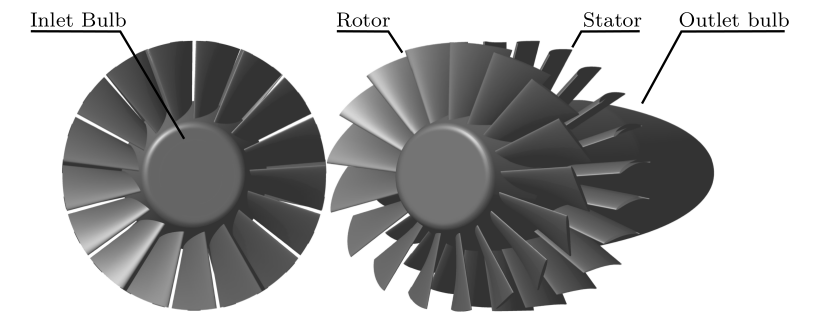
Figure 1. 3D view of the fan